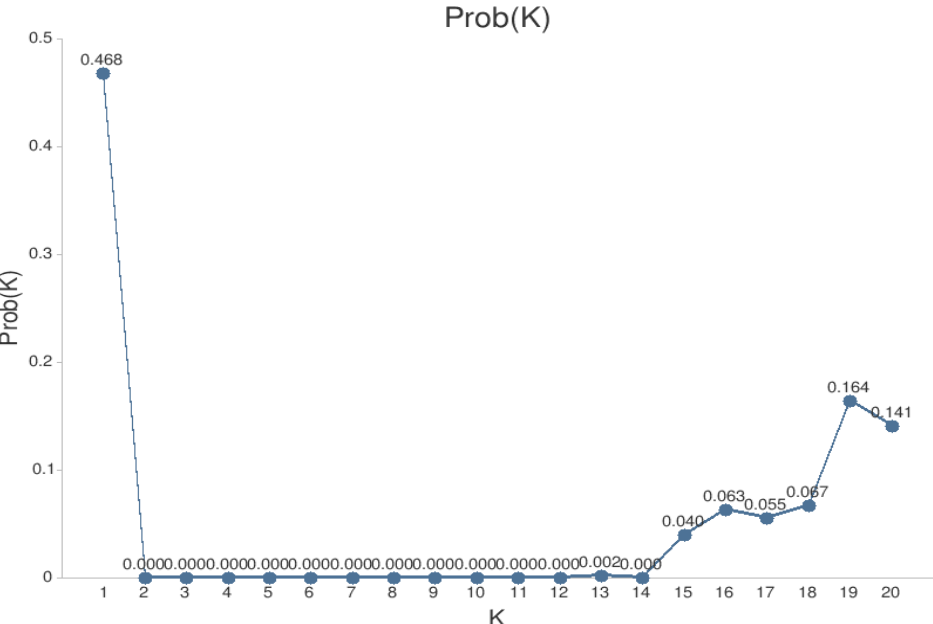
Figure 5. The optimum number of clusters determined using the ln(Pr(X|K)) method [63,64] in CLUMPAK [65].